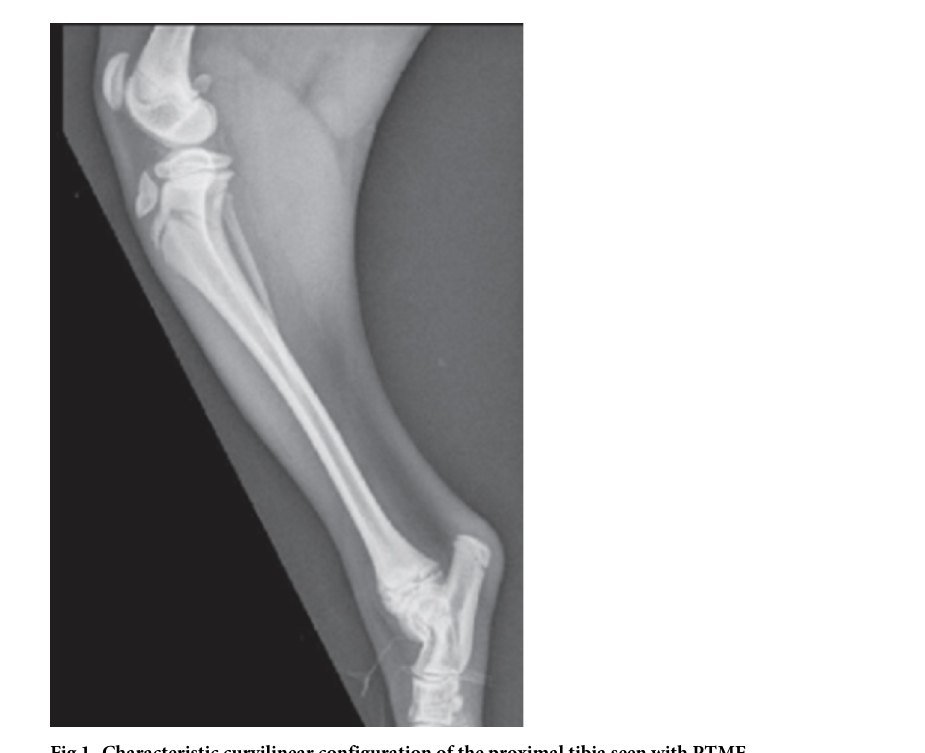
Fig 1. Characteristic curvilinear configuration of the proximal tibia seen with PTMF.